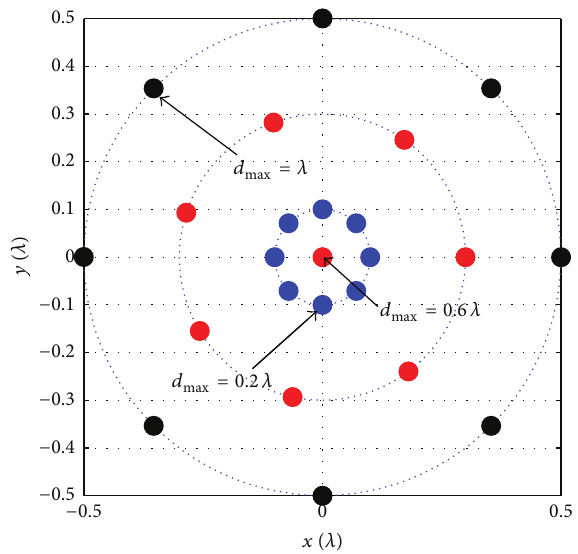
points in red, blue, or black correspond to three difference 𝑑 max constraints. We can see that the optimal layout in this case is the nonuniform linear